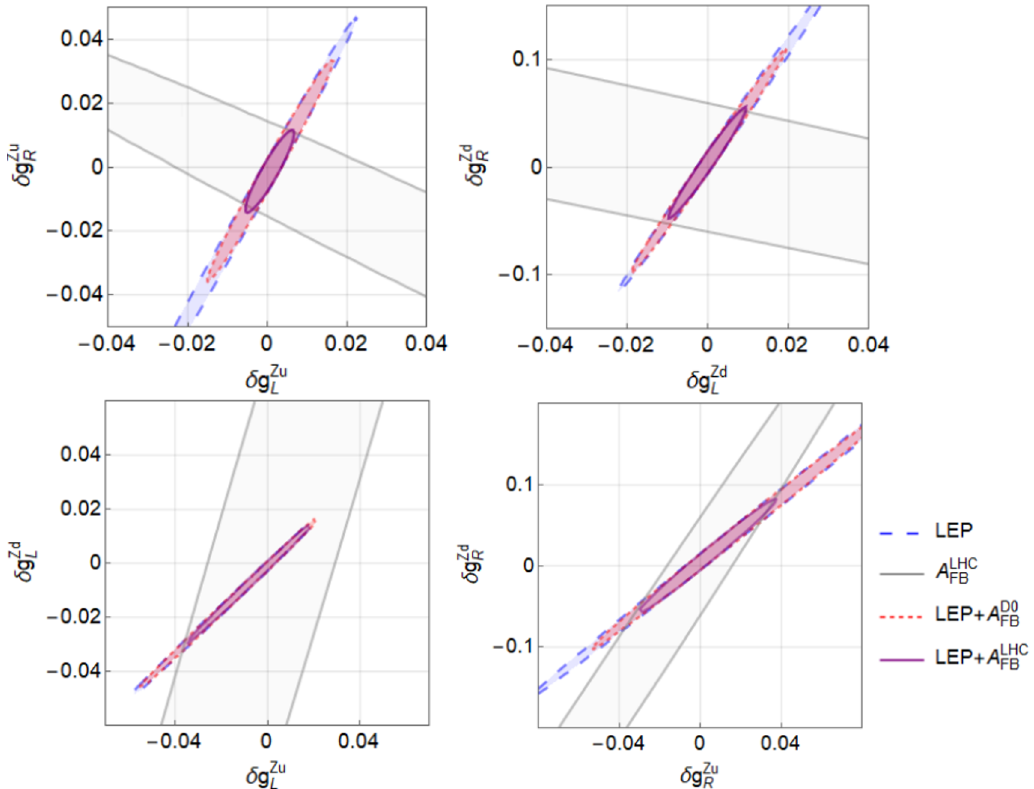
Figure 4 . Allowed regions (at 95% CL) for four pairs of corrections of the Z couplings to light quarks. In each case, only that pair of corrections is different from zero, the rest are given by their SM values. Note the scale is different in each